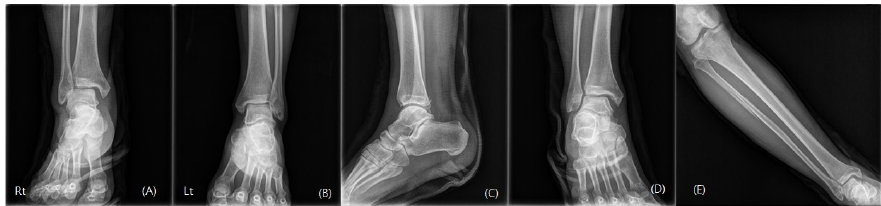
Figure 1. Preoperative plain radiographs showing widening of the medial clear space (( A ) antero- posterior view of the site of injury, and ( B ) anteroposterior view), a posterior malleolar fracture (( C ) lateral view), reduced syndesmosis overlap (( D ) mortise view), and a proximal fibula fracture (( E ) full-length radiograph of the lower leg; anteroposterior view).